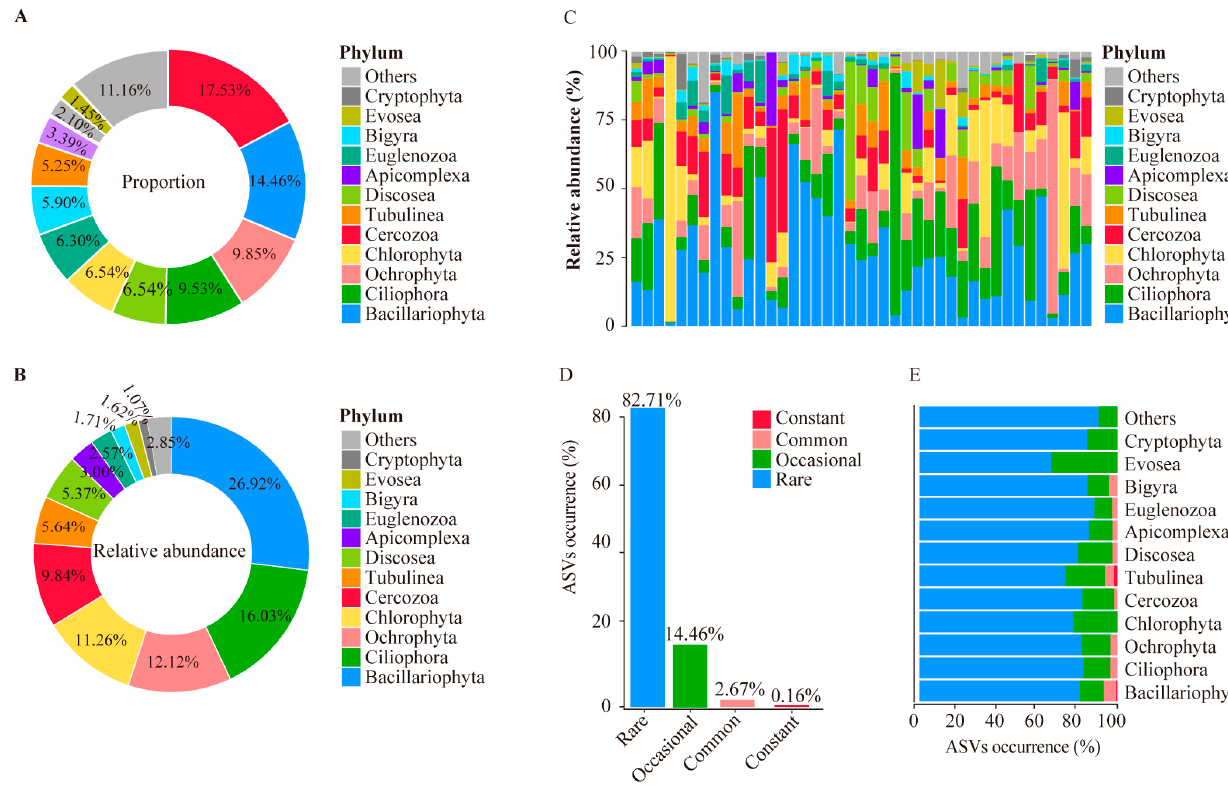
Figure 3. Features of protist community in hot springs in the HGB. ( A ) Percentage of ASVs in different taxa of protists. ( B ) Relative abundance of ASVs in different taxa of protists. ( C ) Relative abundance of ASVs in different taxa per sample. ( D ) Distribution of ASV abundance of protists. ( E ) Distribution of ASV count of protists. ( D ) Occurrence of ASVs in protist communities. ( D ) Occurrence of ASVs in protist communities in different taxa.